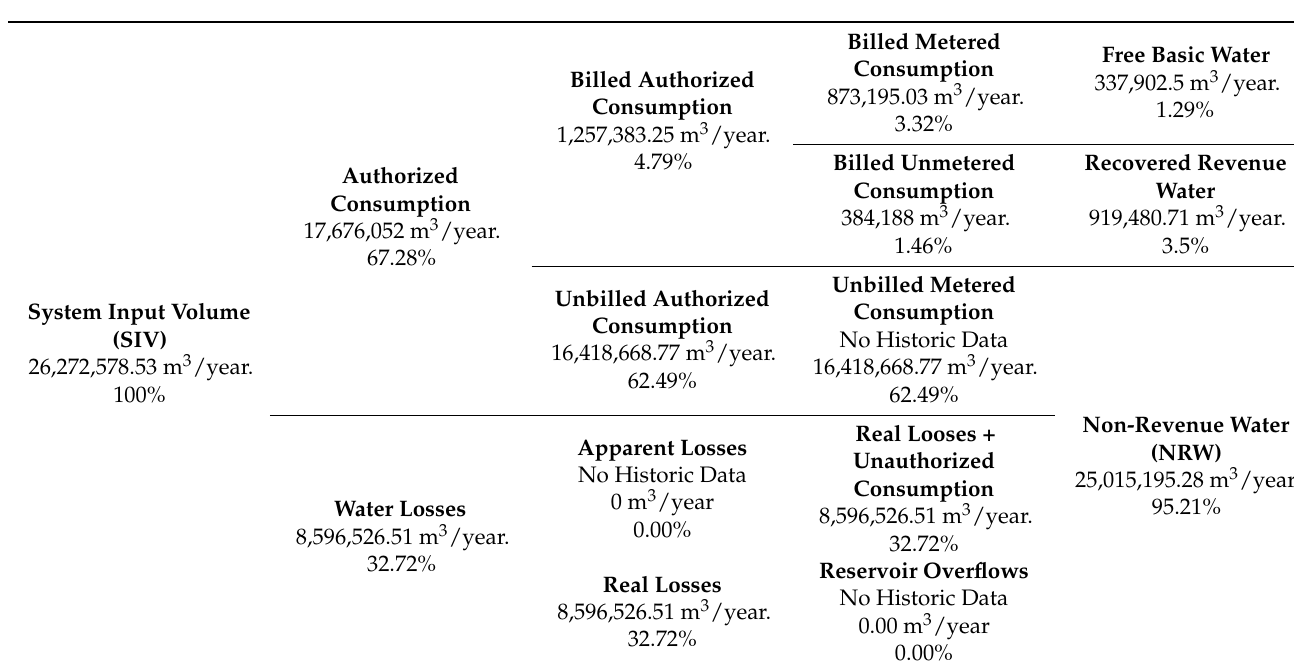
Table 3. Water balance for Alexandra for the 2019/2020 financial